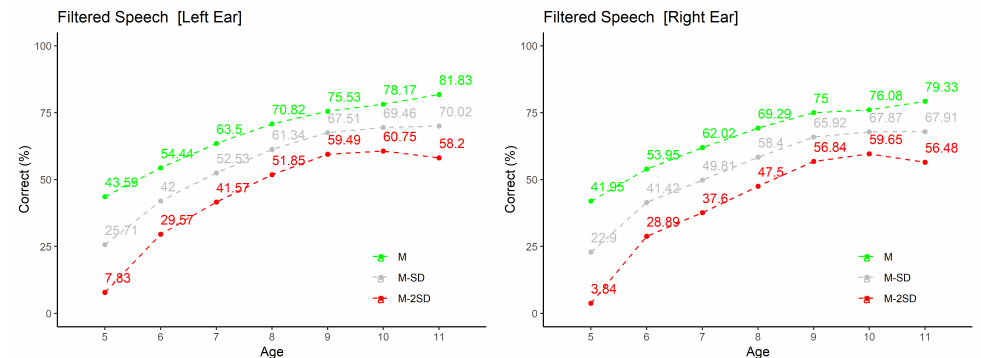
Figure 5. Results for Filtered Speech test: percentage of correct answers obtained in each ear by age group. In addition to the average value (M), M − SD and M − 2SD are shown. GLM results for this test confirm as significant the effect of Age ( p < 0.001). Ear effect is non-significant ( p =